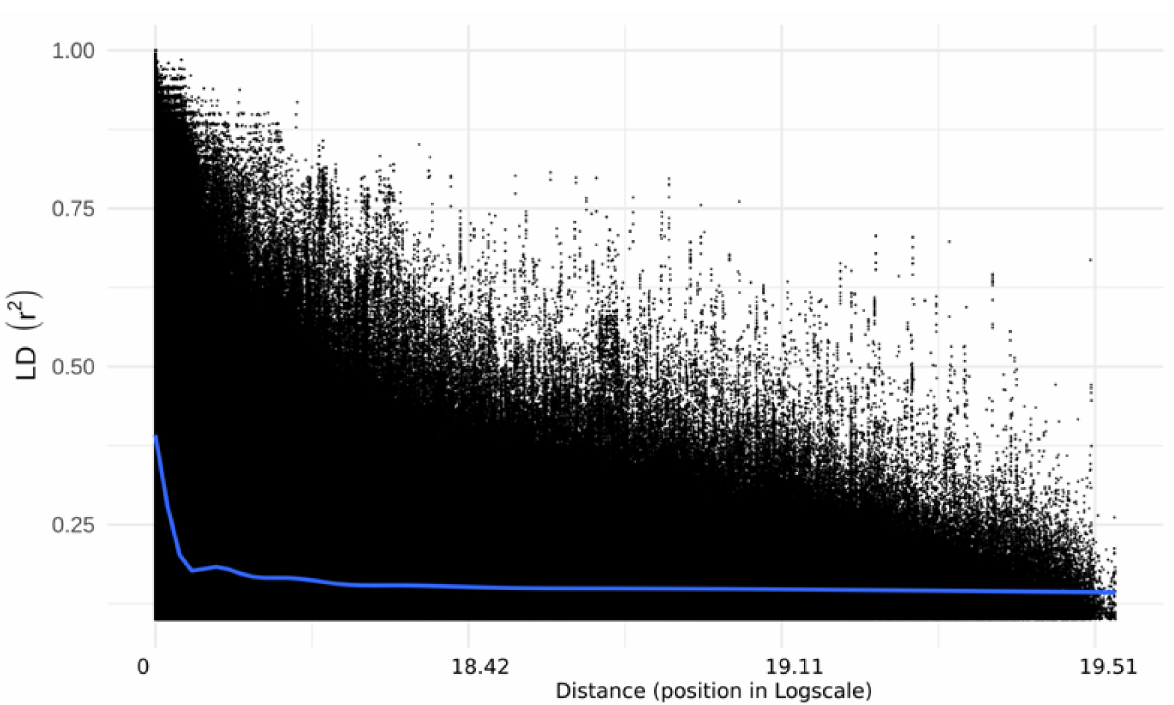
Figure 8. Linkage disequilibrium decay curve based on 60,227 polymorphic SNPs in 384 maize inbred lines. The blue line indicates the general trend in LD decay.